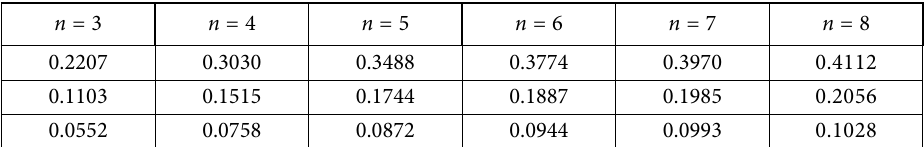
( ) CI P  when a = 0.1 and s = 2 (source: Dong et al., N S